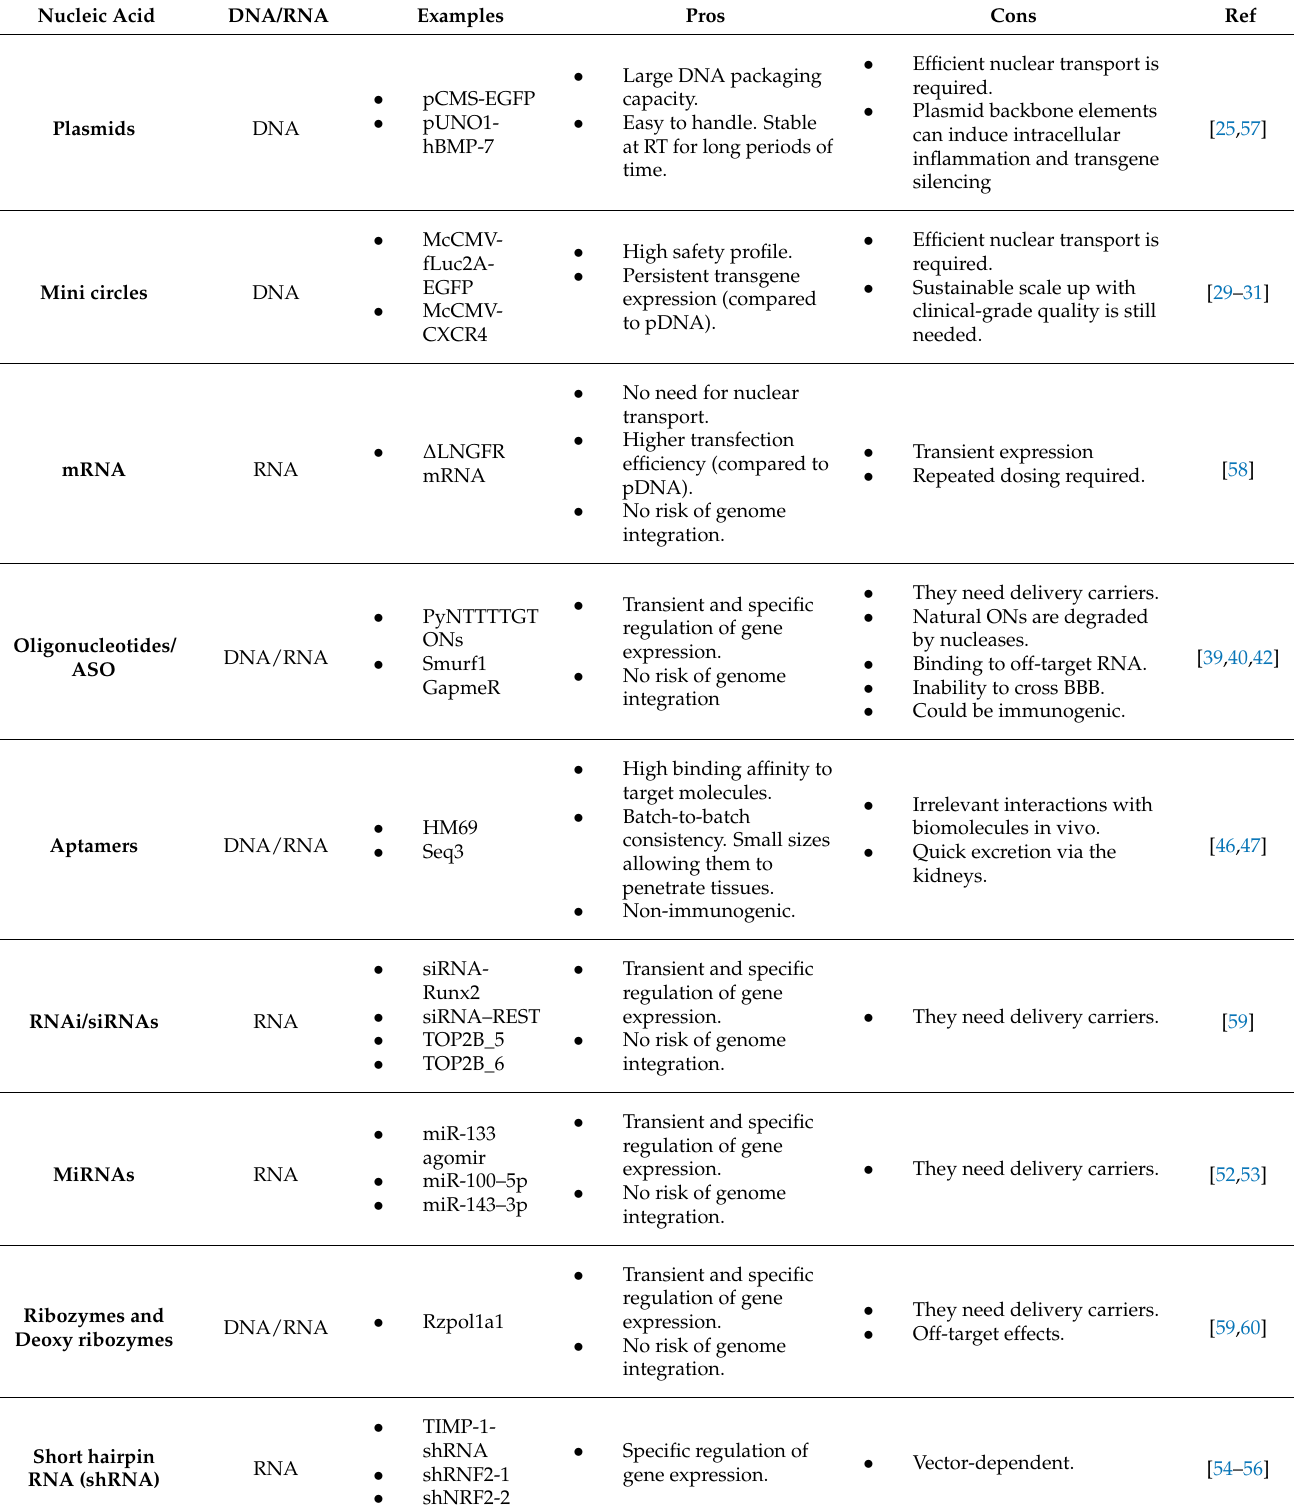
Table 2. A summary of nucleic acids used to transfect MSCs: The advantages and disadvantages. Nucleic